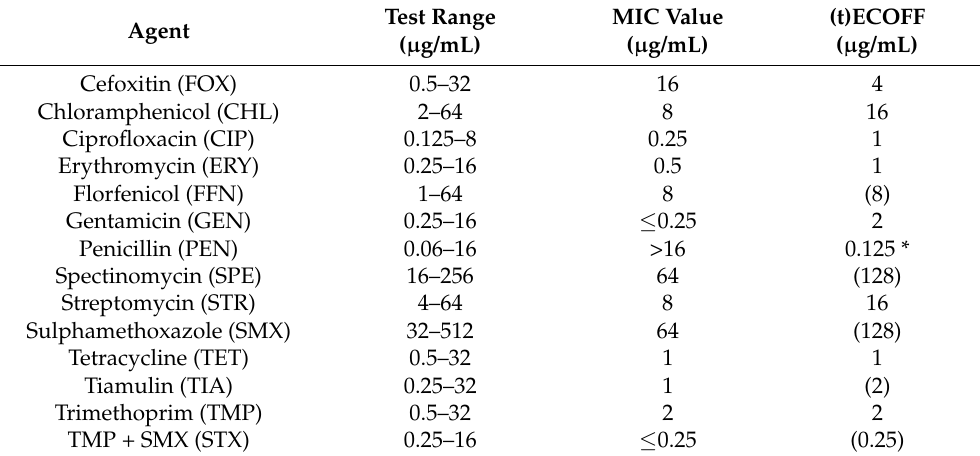
Table 1. MIC values of cefoxitin-resistant S. aureus isolate from a case of bovine clinical mastitis. Test Agent